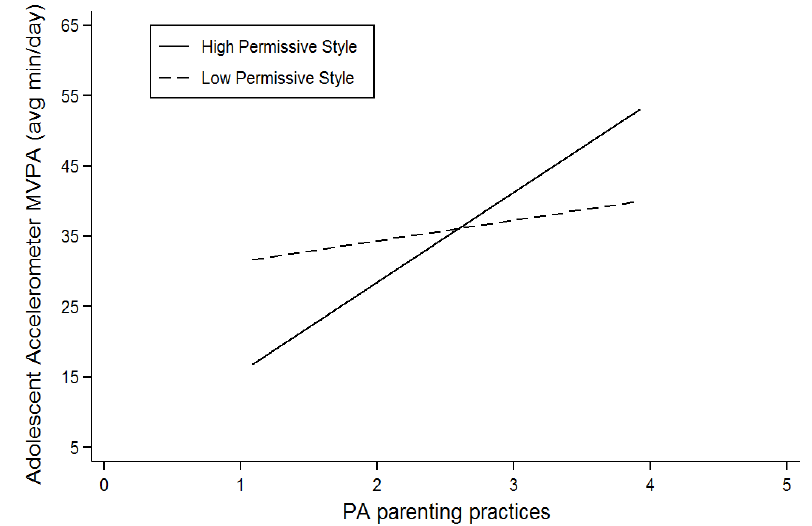
Figure 2. Graph illustrating how associations between adolescents’ amount of moderate-vigorous physical activity (MVPA) and physical activity (PA) parenting practices were moderated by a permissive parenting style. 278